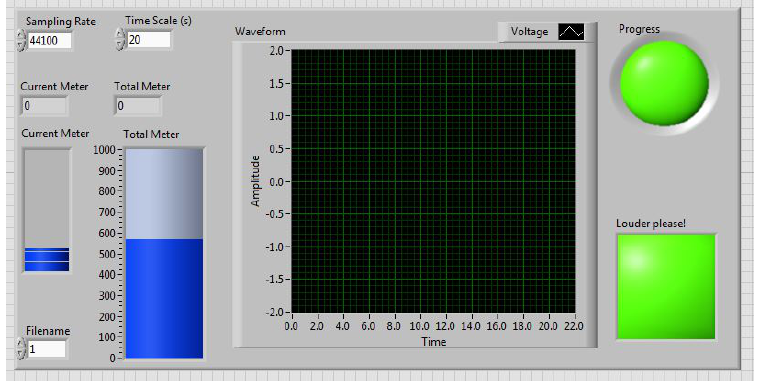
Figure 2. Virtual vocal distance dose monitor.